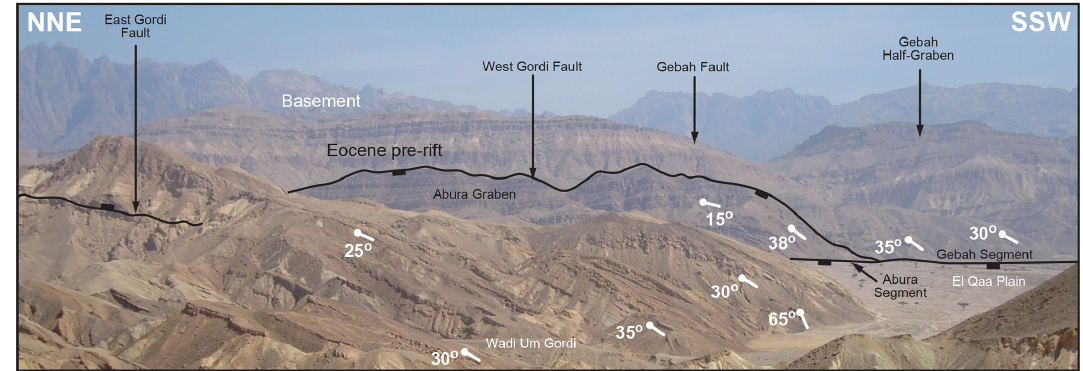
Figure 9. Photograph looking ESE, along-strike of the Theghda Segment. The location of the photo location is shown in Fig.